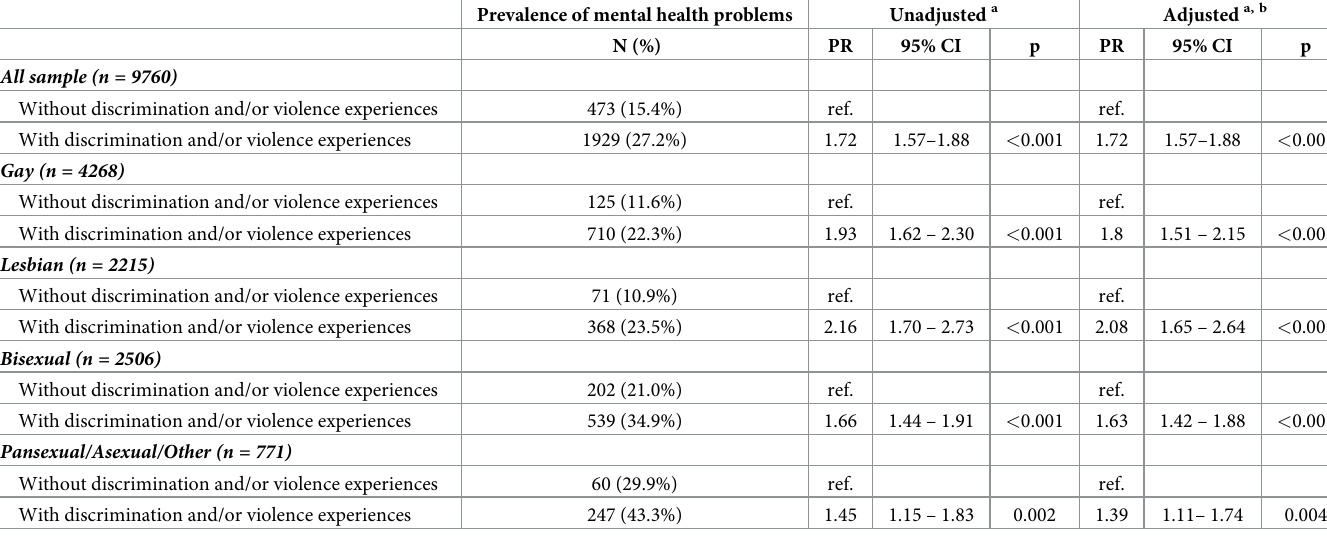
Table 3. Association between discrimination experiences and mental health problems in the last 12 months in the Peruvian sexual